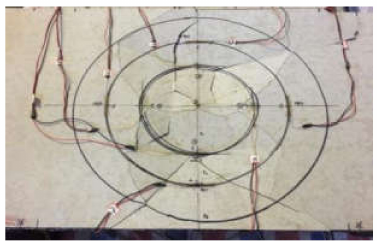
Figure 10. Destruction morphology diagram of W1 specimen.